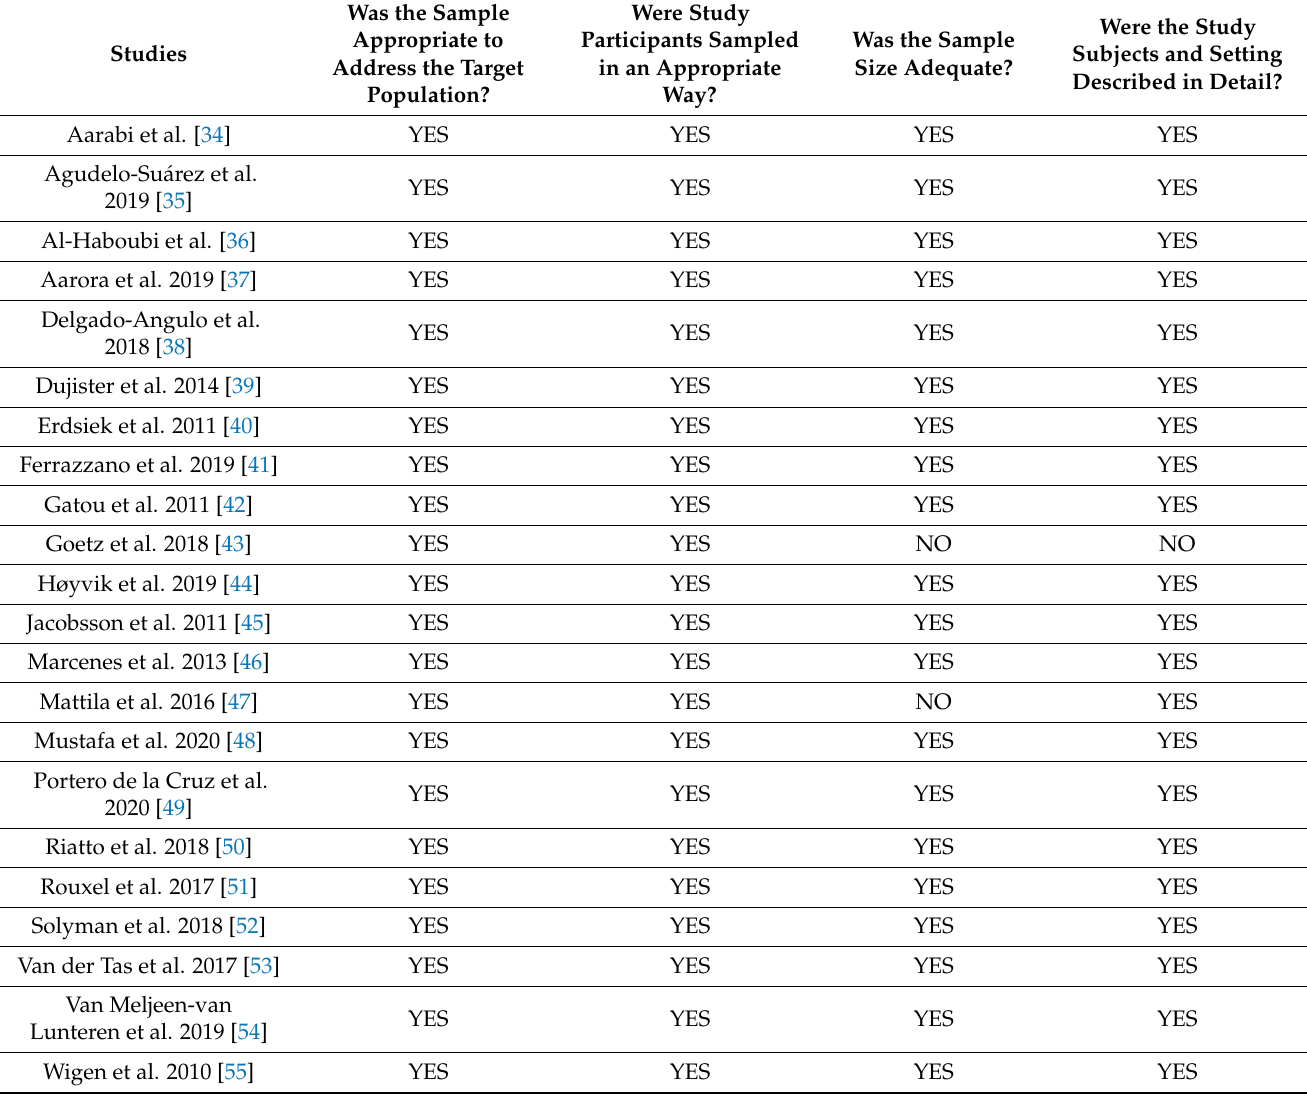
Table 1. JBI for cross-sectional studies: population sample and study